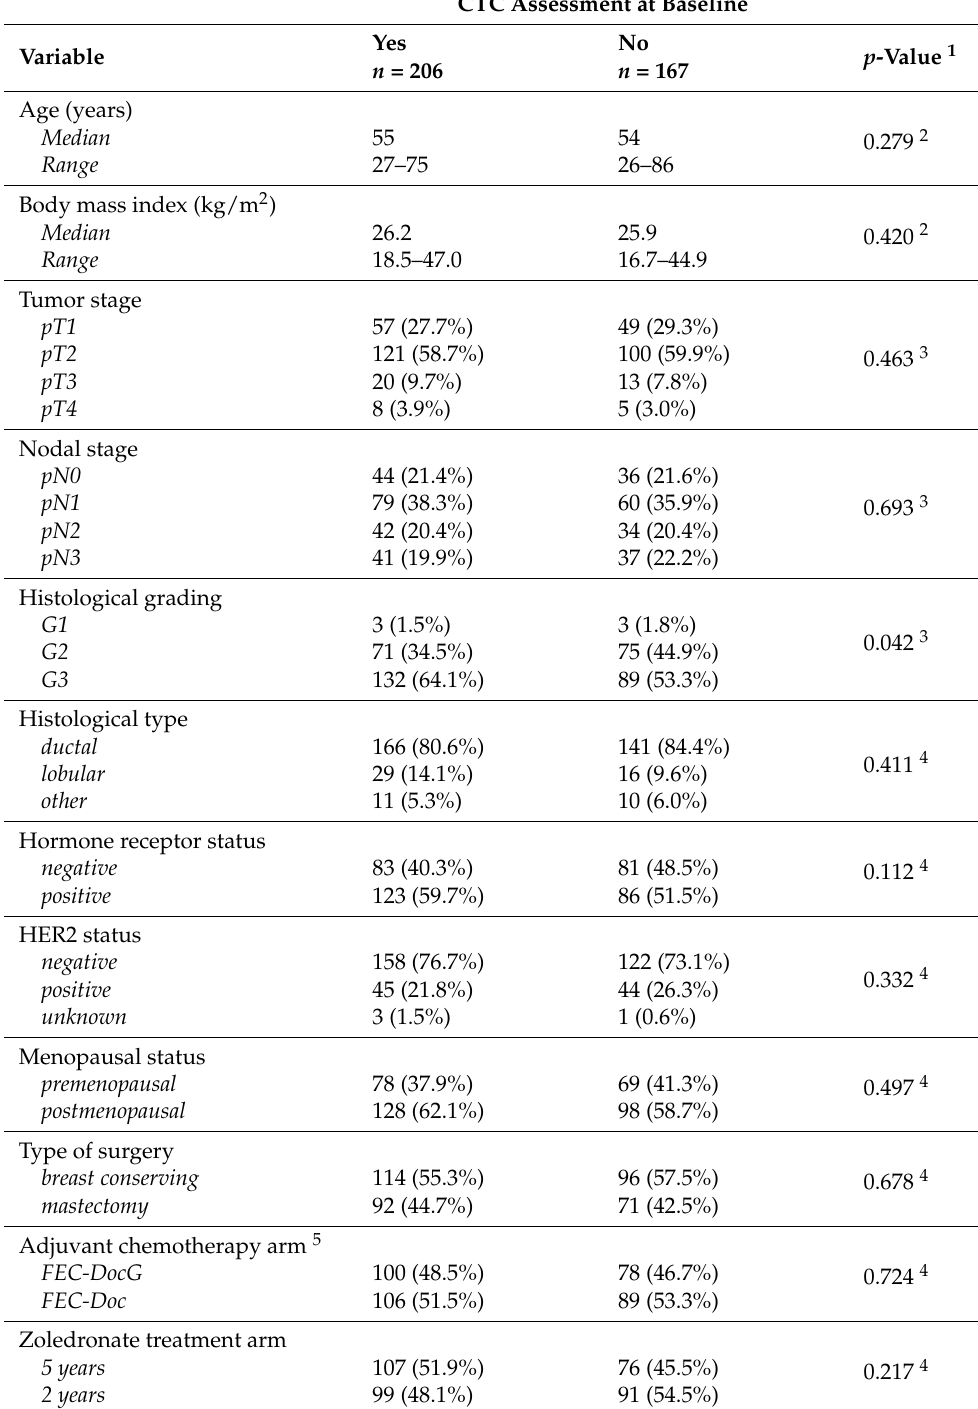
Table 1. Baseline characteristics and clinicopathological variables of patients with early breast cancer recruited in the SUCCESS A trial who developed distant disease according to CTC assessment at baseline before the start of adjuvant chemotherapy